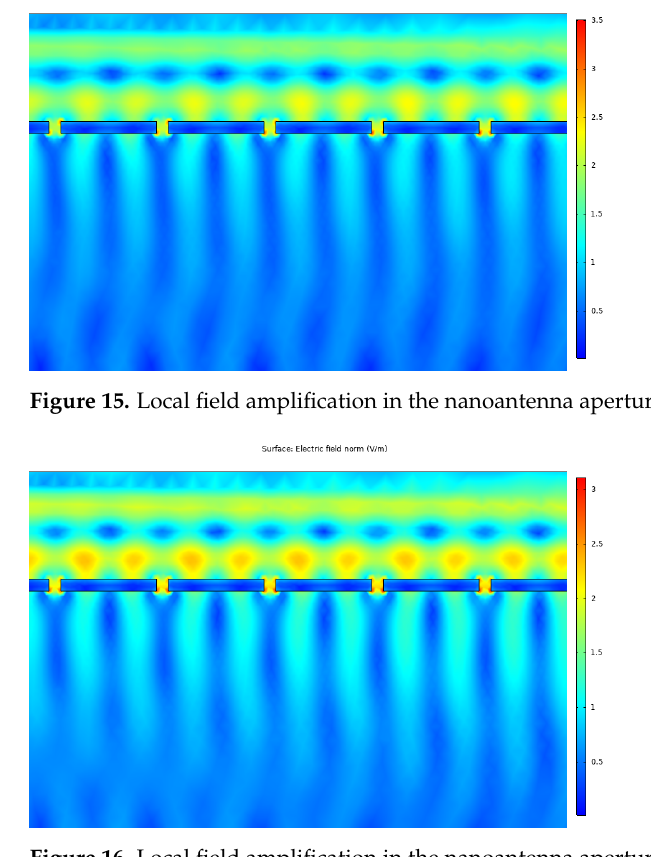
Figure 16. Local field amplification in the nanoantenna apertures for silver